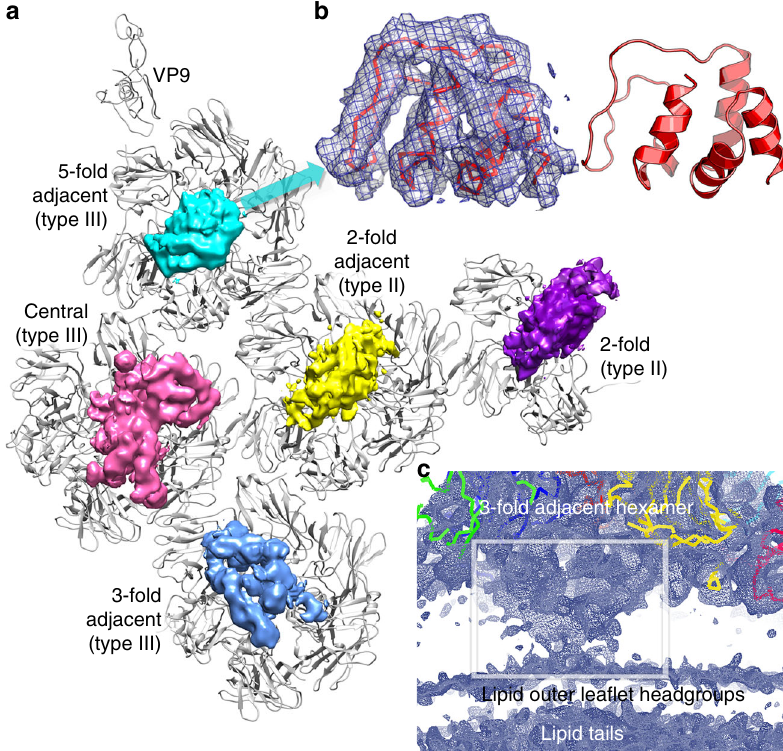
Fig. 3 Sub-hexamer proteins. a View from inside of an icosahedral unit of the capsid. VP9, VP7 and VP4 are shown in grey and the hexamers are labelled. The cryo-EM map shows the density for the sub-hexamer proteins (blurred by the application of a B-factor of 100 Å 2 ). b Close-up of density (blurred by the application of a B-factor of 100 Å 2 ) under the 5-fold adjacent hexamer, showing fi tted 80 residues of VP13, side view. c Lower contour level side view of the density under the 3-fold adjacent